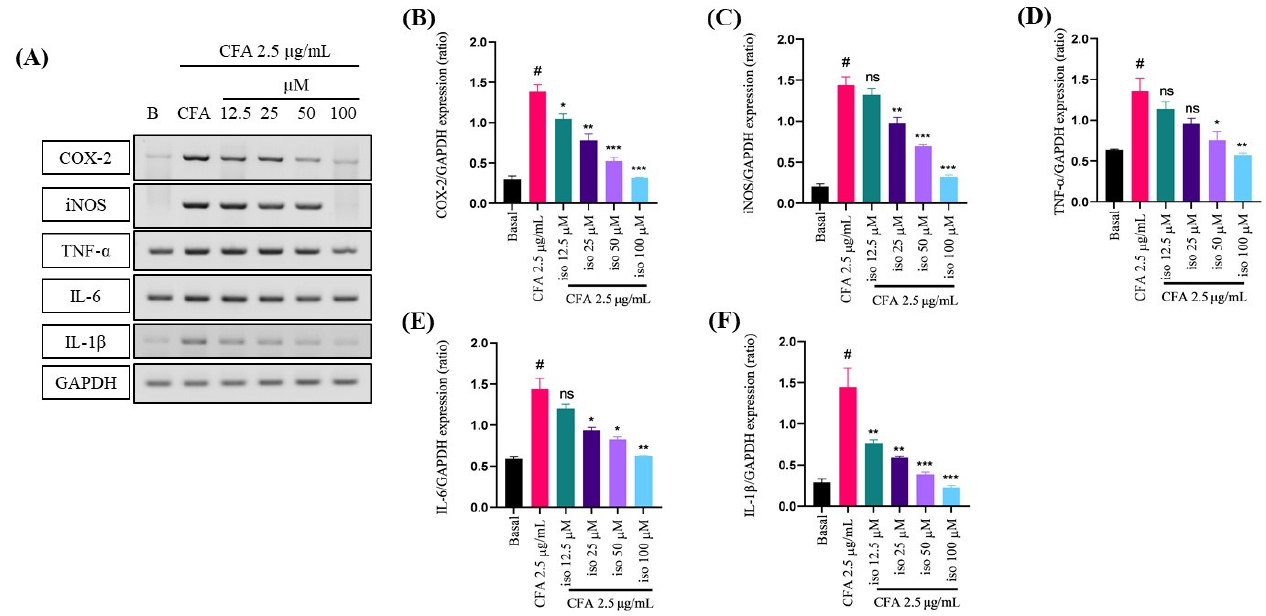
Figure 2. Effect of isoleucilactucin on CFA-induced proinflammatory mediators and cytokines in MH-S cells analyzed using reverse transcription polymerase chain reaction (RT-PCR). ( A ) RT-PCR analysis was performed to evaluate the mRNA levels of proinflammatory mediators, such as cyclooxygenase 2 (COX2) and inducible nitric oxide synthase (iNOS), as well as proinflammatory cytokines, such as tumor necrosis factor-alpha (TNF- α ), interleukin (IL)-6, IL-1 β , and GAPDH. ( B – F ) ImageJ was used to perform quantitative analysis of the relative mRNA expression levels. Isoleucilactucin dosages of 12.5, 25, 50, and 100 μ M were used to seed the cells in a 6-well plate. Values from three independent experiments were expressed as the mean ± SEM ( n = 3). Compared with the basal group, ns: not significant, # p < 0.001; compared with the CFA group, * p < 0.05, ** p < 0.01, and *** p < 0.001.